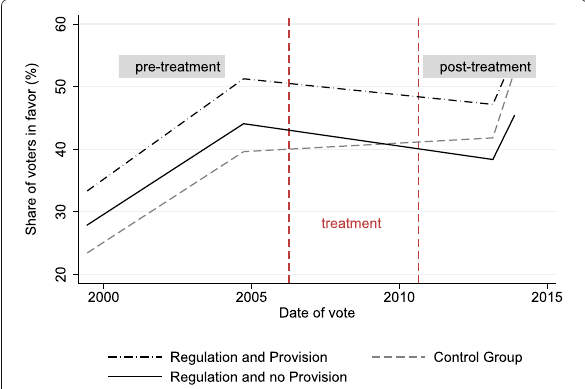
Fig. 5 Vote outcomes of bills promoting maternal employment in the municipalities with no regulation (mun. in the control cantons), municipalities with regulation but no provision, and municipalities with regulation and provision. The results displayed show population weighted means in vote outcomes for each of the three groups